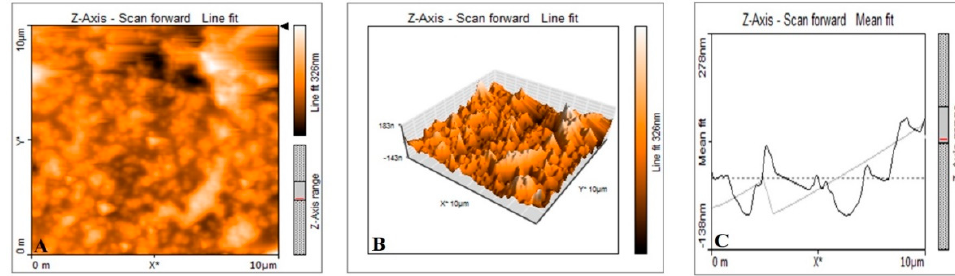
Figure 7. AFM analysis of synthesized P-AgNPs from P. alba leaf extract. ( A ) Two dimensional depiction, ( B ) size distribution, and ( C ) histogram.